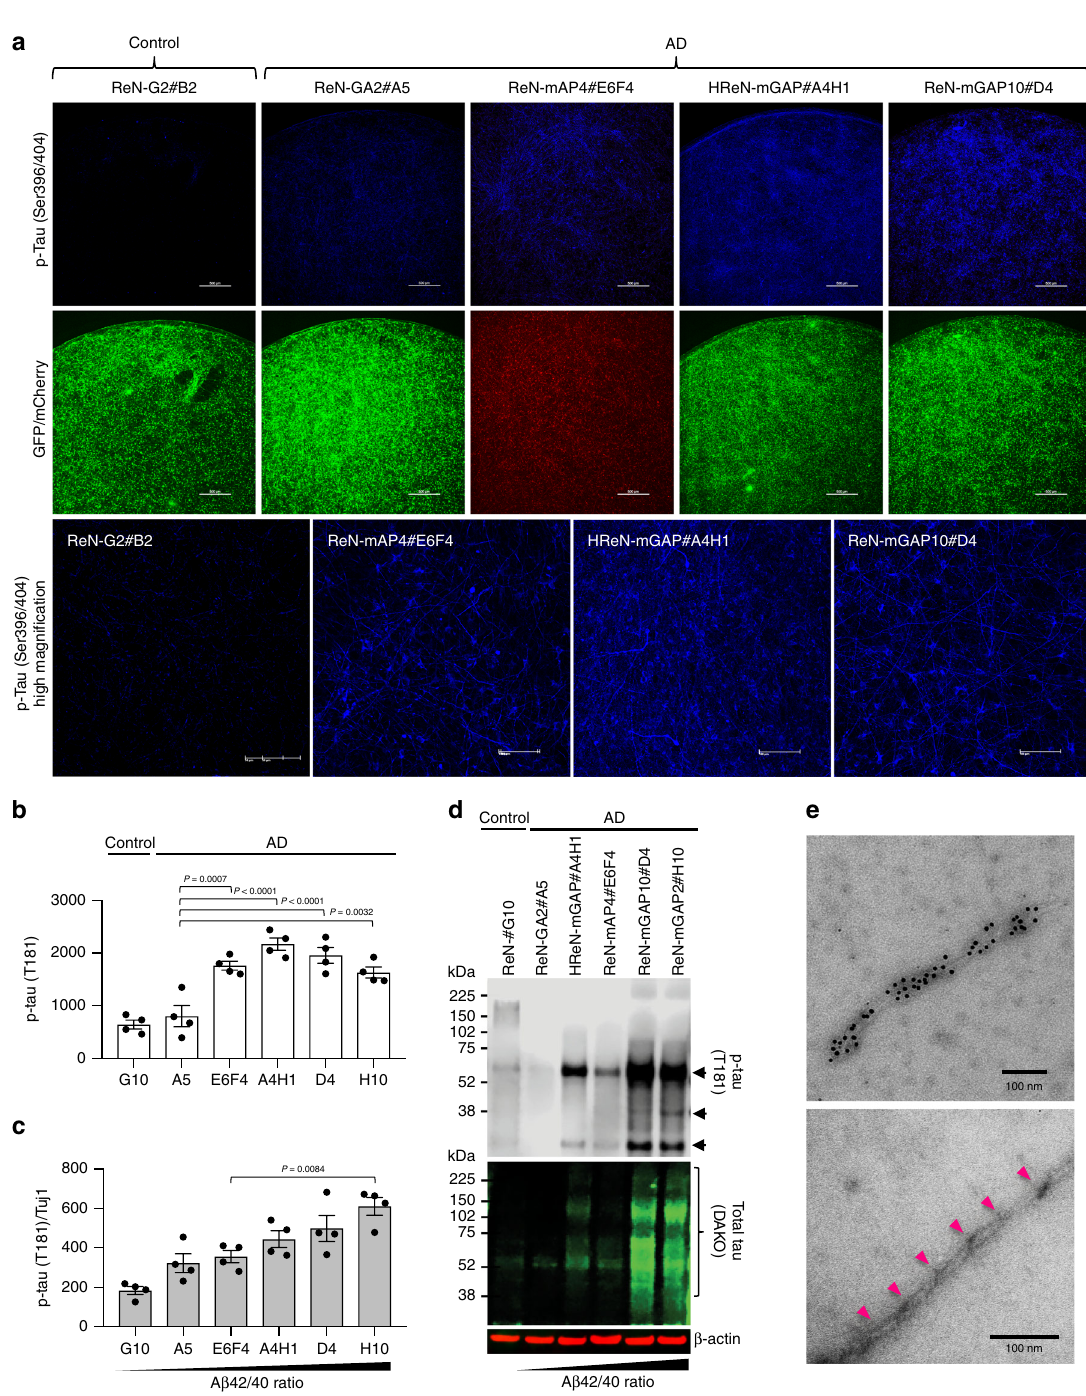
Fig. 4 A β 42/40 ratio regulates tau pathology in 3D-differentiated FAD hNPCs. a Clonal control and FAD hNPCs (3 × 10 5 ) were 3D-differentiated in 96- well fl at-bottom plates for 6 weeks. After fi xing with 4% paraformaldehyde solution, cells were immunostained with antibody against p-tau (PHF1; Ser396/ 404). Enlarged images of PHF1-positive cells in ReN-G2#B2, ReN-mAP4#E6F4, HReN-mGAP#A4H1, and ReN-mGAP10#D4 are presented. Scale bars represent 500 μ m. b Clonal control and FAD hNPCs (3 × 10 5 ) were 3D-differentiated in 96-well plates for 6 weeks. Total proteins were extracted by dissolving in 5 M GuHCl lysis buffer. Levels of p-tau (T181) were measured by ELISA assay. c Levels of p-tau (T181) in 3D-differentiated clonal hNPCs were normalized by Tuj1. All data are expressed as mean ± SEM of four independent repeats (black dots). Statistical signi fi cances were determined by one-way ANOVA with Tukey ’ s multiple comparisons test. d Cells (1.2 × 10 6 ) were 3D-differentiated in 24-well plates for 6 weeks. Samples were harvested and lysed in 1% sarkosyl lysis buffer. Sarkosyl-insoluble proteins were fractioned by ultracentrifugation. Western blot analysis was performed to identify p-tau (T181) (top panel) and total tau (bottom panel) in the clonal hNPCs. For the loading control, β -actin in the sarkosyl-soluble fraction was used. e Representative electron micrographs show tau fi brils. Sarkosyl-insoluble fractions were puri fi ed from a 3D culture of 9-week differentiated ReN- mGAP10#D4. The tau fi brils were labeled with anti-tau antibody (T46)-conjugated gold nanoparticles (top panel). Scale bars represent 100 μ m. The helical structures in tau fi brils are presented (bottom